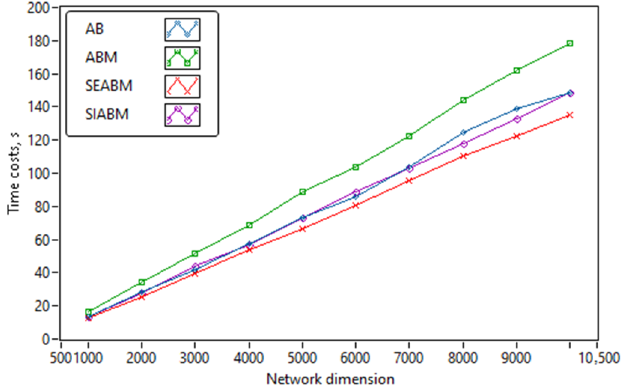
Figure 9. Time costs on the simulation with a fixed integration step h = 0.01 depending on the di- mension of the network. dimension of the